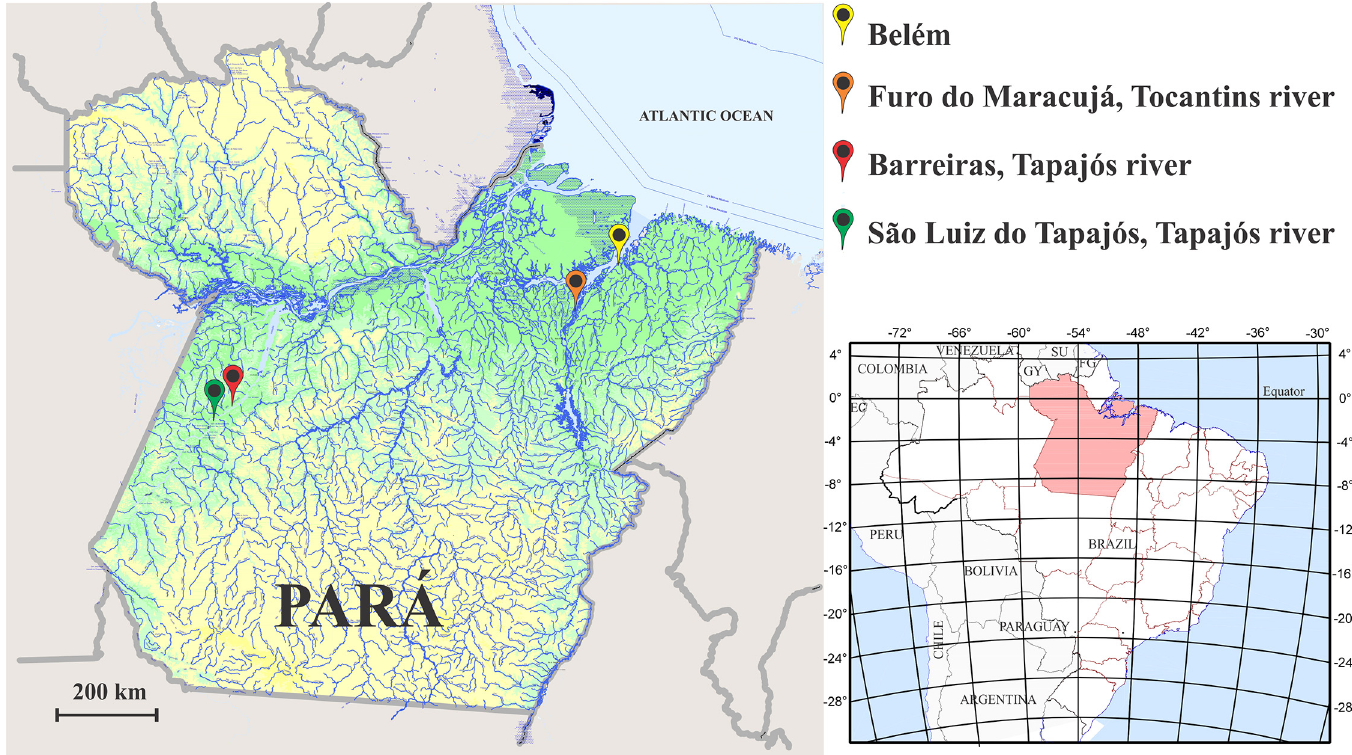
Fig 1. State of Pará, Brazil. The somatosensory functions of inhabitants from two communities of the Tapajós river basin, Barreiras and S ã o Luiz do Tapajós, and one community of the Tocantins river basin, Furo do Maracujá, were studied with psychophysical methods. Barreiras and S ã o Luiz do Tapajós were mercury-exposed due the proximity of gold-mining areas. The map was obtained from the Instituto Brasileiro de Geografia Estatística – IBGE. Modified from: ftp://geoftp.ibge.gov.br/mapas_tematicos/fisico/unidades_federacao/pa_fisico.pdf